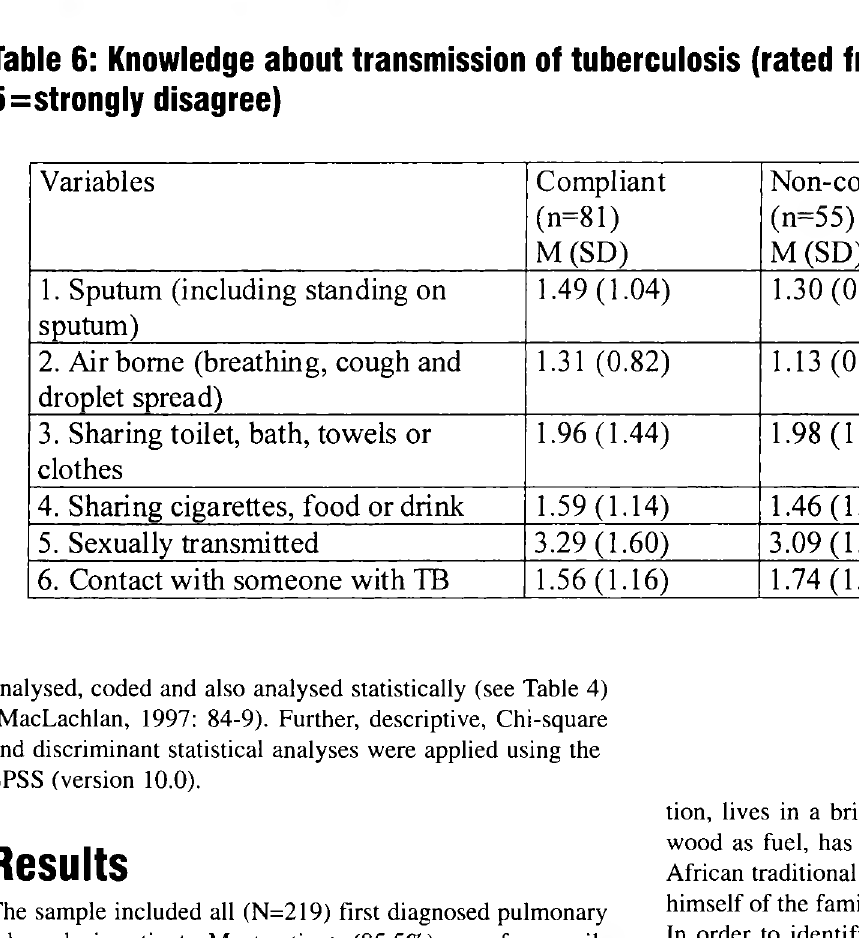
Help-seeking for TB